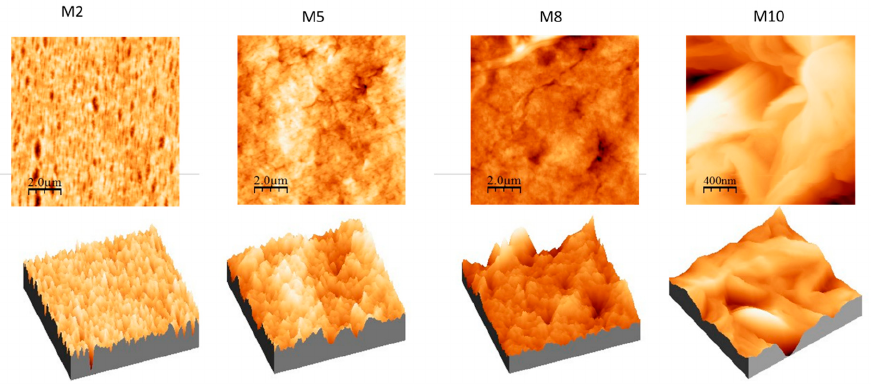
Figure 8. AFM images with corresponding 3D views of M2, M5, M8 and M10 membranes deriving from films exposed to humidity for 2.5 min during